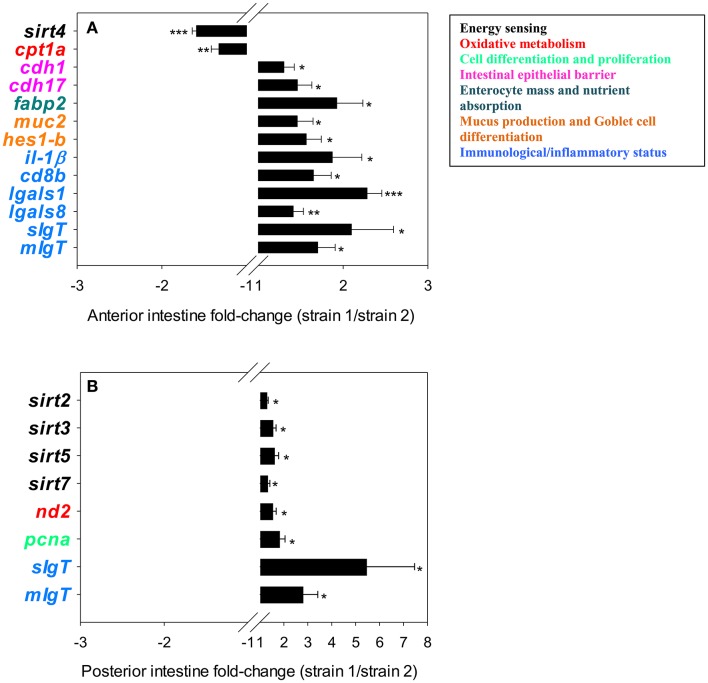
Fold-changes (strain 1/strain 2) of differentially expressed genes in the anterior (A) and posterior (B) intestinal segments. The asterisks indicate statistically significant differences (*P < 0.05, **P < 0.01, ***P < 0.001) between strains. Values >1 indicate up-regulated genes in fish of strain 1; values <1 indicate down-regulated genes in fish strain 1.